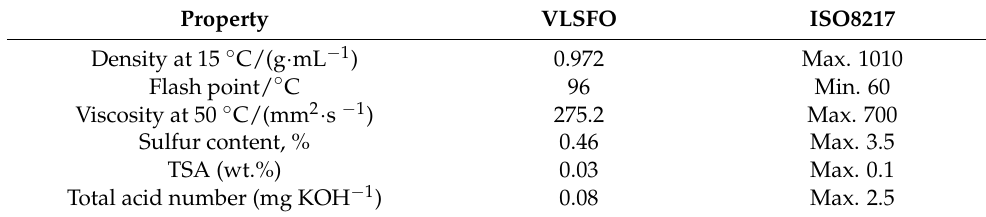
Table 1. Basic Characterization of VLSFO.